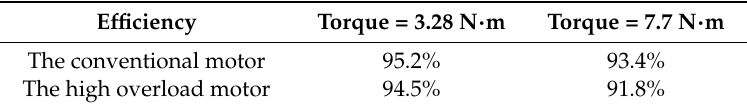
Figure 10. A comparison of motor loss distribution. Table 2. The efficiency with different torque.